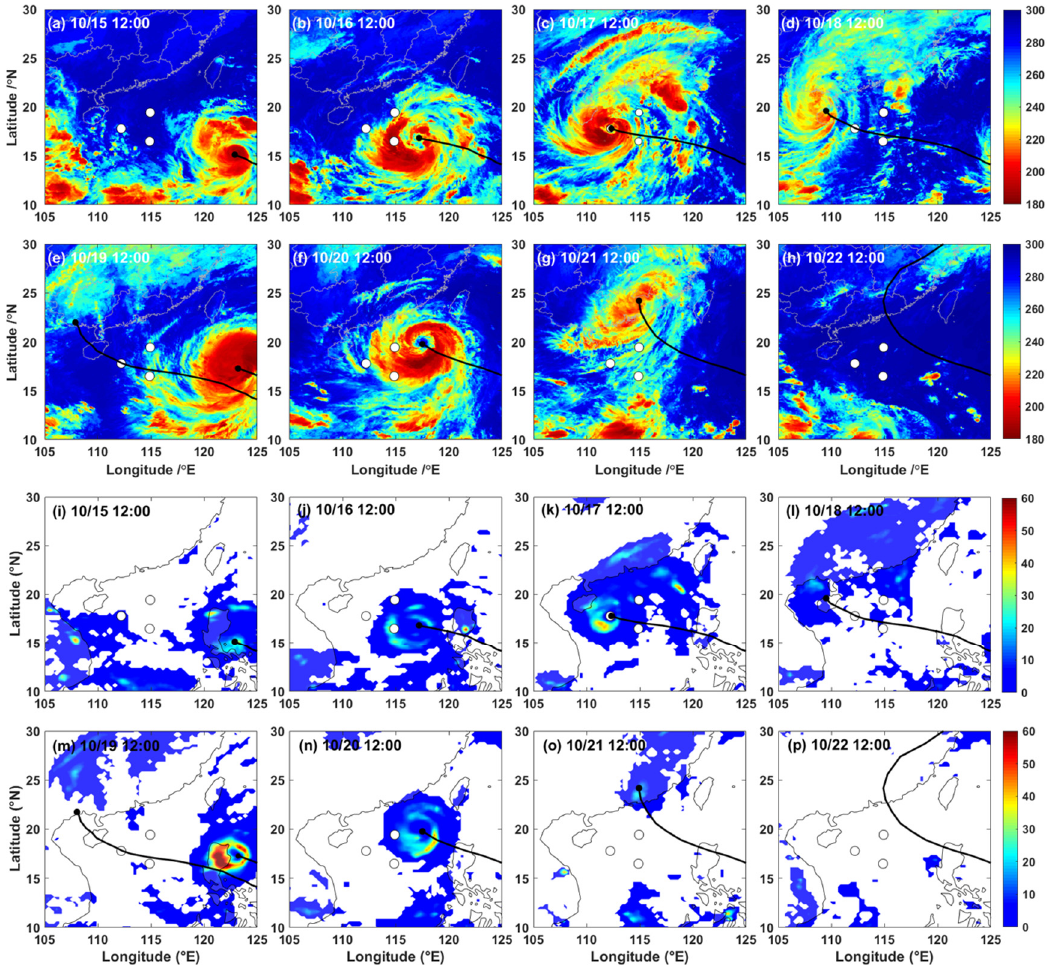
Figure 3. ( a – h ) Cloud-top brightness temperatures obtained by the Himawari-8 satellite at 12:00 UTC between October 15 and 22, and ( i – p ) corresponding rainfall data obtained by the CPC MORPHing technique (CMORPH) data. The white hollowed dots indicate the buoy and mooring stations; the black lines indicate the tropical cyclone tracks; and the black dots indicate the centers of the tropical